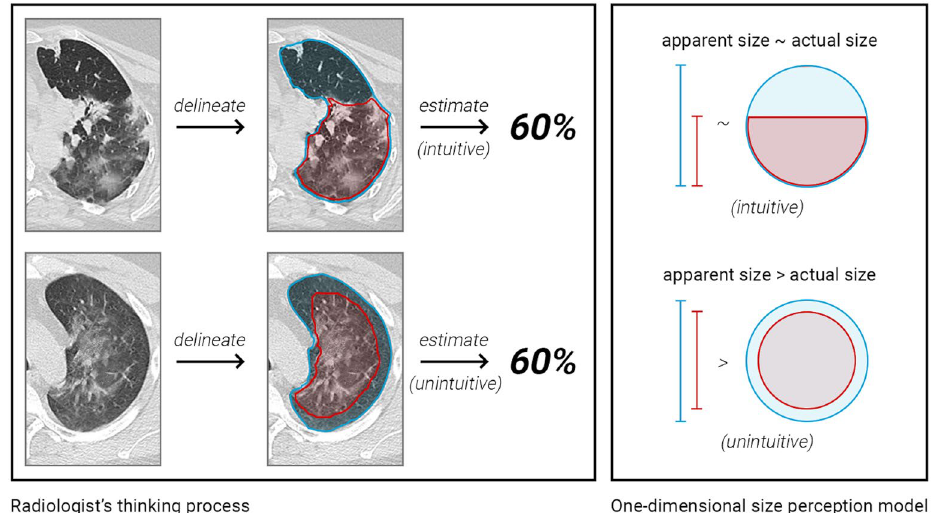
Figure 1. COVID-19 quantification judgement process (left) compared to the circle size comparison problem (right). In both cases, the apparent proportion of COVID-19 involvement (red) in relation to total lung area (blue) appears greater in the bottom examples. This is due to the overinfluence of a primary linear dimension (1D segment ratio = 80%) that is often insufficiently adjusted to the 2D context (2D circle ratio = 60%). This leads to an overestimation of the perceived